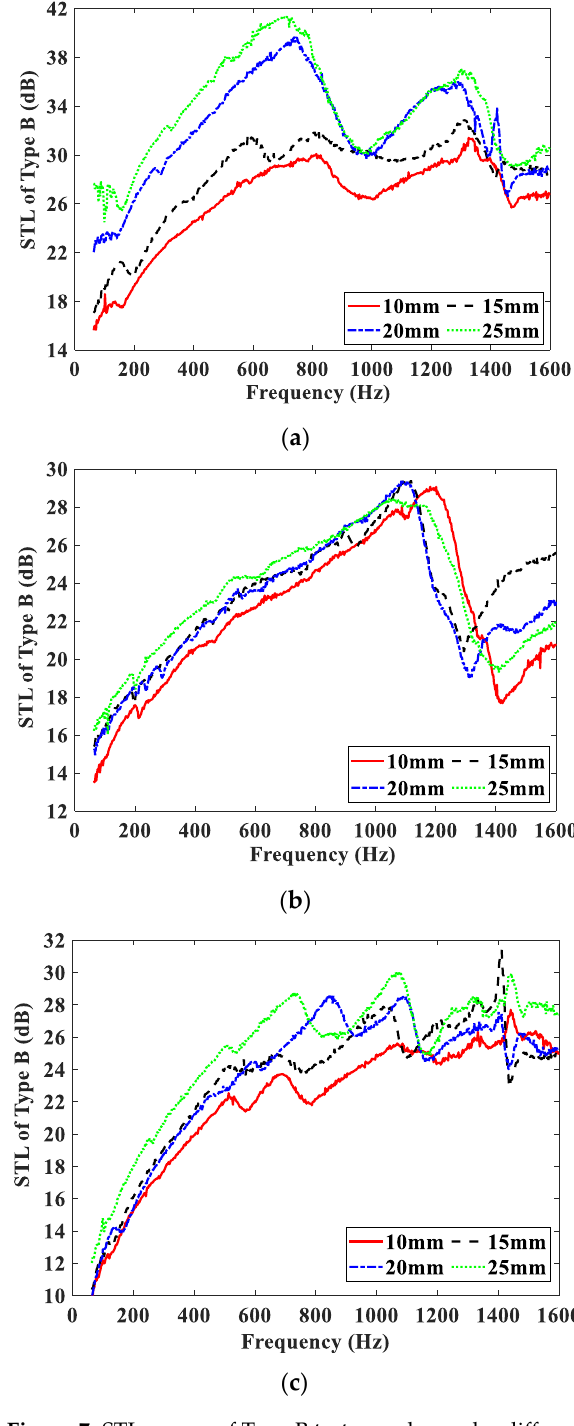
Figure 7. STL curves of Type B test samples under different magnetic field intensities. ( a ) Embedded with MRF unit; ( b ) embedded with air unit; ( c ) embedded with water unit.